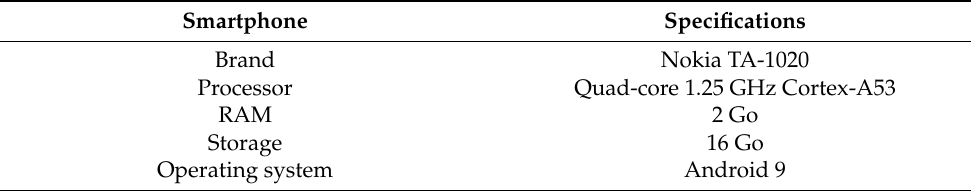
Table 2. Hardware specifications of the tested smartphone.